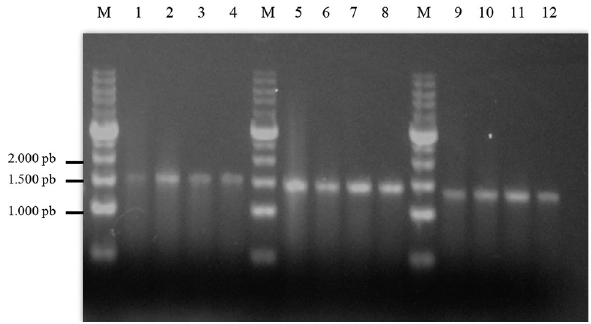
Figure 1 - Agarose gel electrophoresis of PCR products of Mper ERG11 amplified from genomic DNA. The reactions were done with an annealing temperature gradient. M - molecular weight marker (1 kb; Amresco). 1-5 - genomic PCR products with no region corresponding to the signal peptide (1,858 bp), 6-10 - genomic PCR products without the first transmembrane insertion (1,712 bp), 11-15 - genomic PCR products without the first and second transmembrane insertions (1,575 bp).